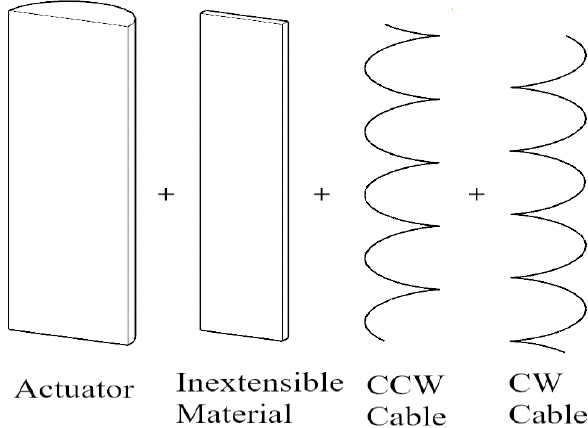
Figure 1. Bending design of soft pneumatic actuator.